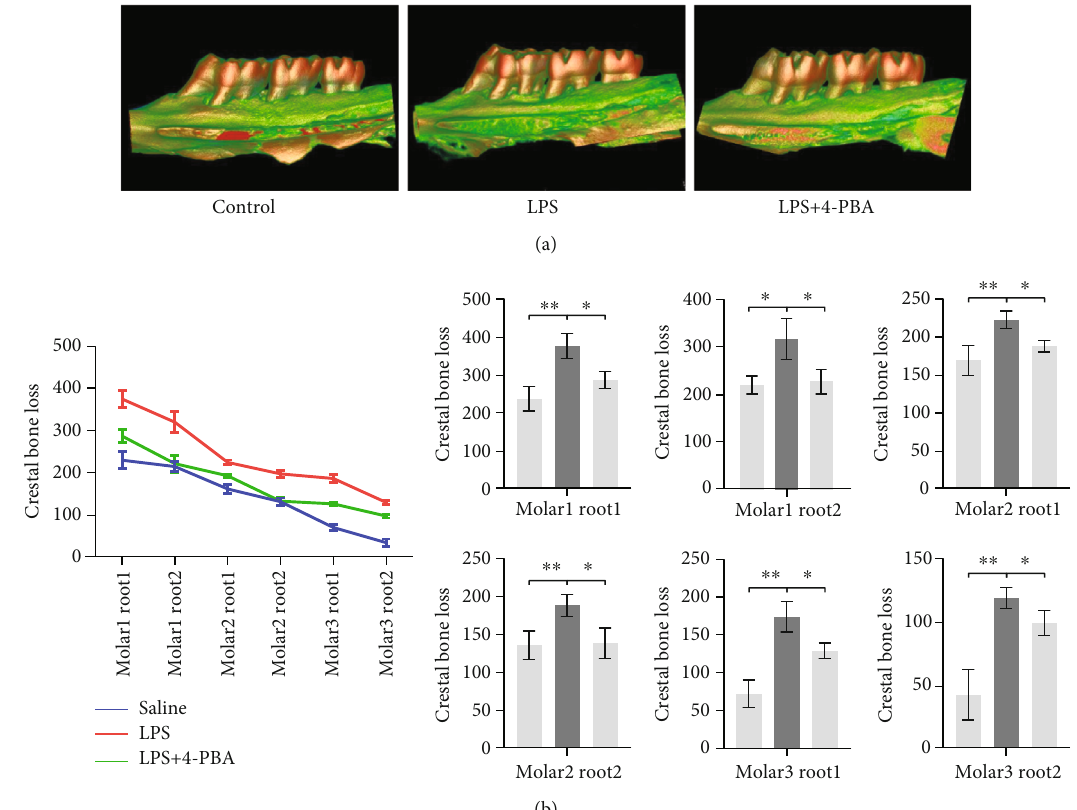
Figure 5: Local administration of 4-PBA rescues alveolar bone resorption in an LPS-induced periodontitis rat model. (a) Micro-CT acquired the representative images of the alveolar bone loss. (b) Alveolar bone resorption analysis of maxillary molars. Six sites for three molars were analyzed morphometrically (one site for each root of one tooth). The distance between the cement-enamel junction (CEJ) and alveolar crest of the mesial and distal roots of the three maxillary molars was assessed under a stereoscopic microscope. The results indicated more alveolar bone loss in the LPS (10 μ g/day) treated groups compared to the saline group (10 μ l). Local administration of 4-PBA (5 nmol/day) rescued the bone resorption induced by LPS. The data represent mean ± standard deviations ( n = 3 ). ∗ P < 0 : 05 , ∗∗ P < 0 : 01 , ∗∗∗ P < 0 : 001 . Table 2: E ff ect of 4-PBA local administration on rats with experimental periodontitis. The body weight, heart/body weight, liver/body weight, spleen/body weight, adrenal gland/body weight, and kidney/body weight were analyzed in the saline group, LPS group, and LPS in combination with the 4-PBA group. The data represent mean ± standard deviations ( n = 3 ). ∗ P < 0 : 05 . Saline ( × 10 -3 kg) LPS ( × 10 -3 kg) LPS+4PBA ( × 10 -3 kg)